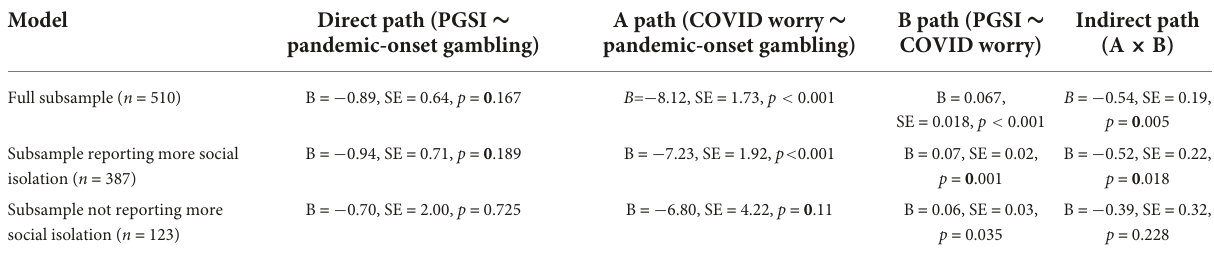
TABLE 2 Mediation